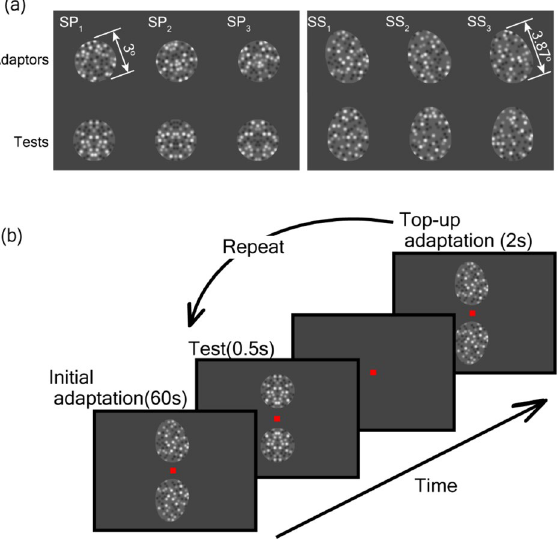
Figure 1. ( a ) Examples of stimuli with symmetry of pattern (SP; left) and shape (SS; right). In these examples, the symmetry axes of the adaptors (the top row) were tilted − 10° (anticlockwise) from the vertical direction, while those of the tests (the bottom row) were vertical. The numbers in white on the top left of each stimulus identify distinct dot patterns. In the stimuli with SP, the corresponding adaptor and test (sharing the same column) had the same dot pattern, but their luminance contrast was inverted to avoid influence from the contrast. In the stimuli with SS, dot patterns were random and different between the adaptor and test. ( b ) An illustration of the experimental procedure. A pair of adaptation stimuli were shown for 60 s, and a pair of test stimuli were then presented for 0.5 s. The stimulus pairs consisted of the same stimulus with their symmetry axes tilted in the opposite directions. In this example, the adaptors on the top and bottom were tilted anticlockwise (–θ) and clockwise (+ θ) from the vertical direction, respectively. The participants were asked to indicate which stimulus was tilted clockwise from the vertical during the presentation of a blank screen. Immediately after the answer, a pair of top-up adaptors were presented for 2 s. The trial was repeated 25 times using the staircase